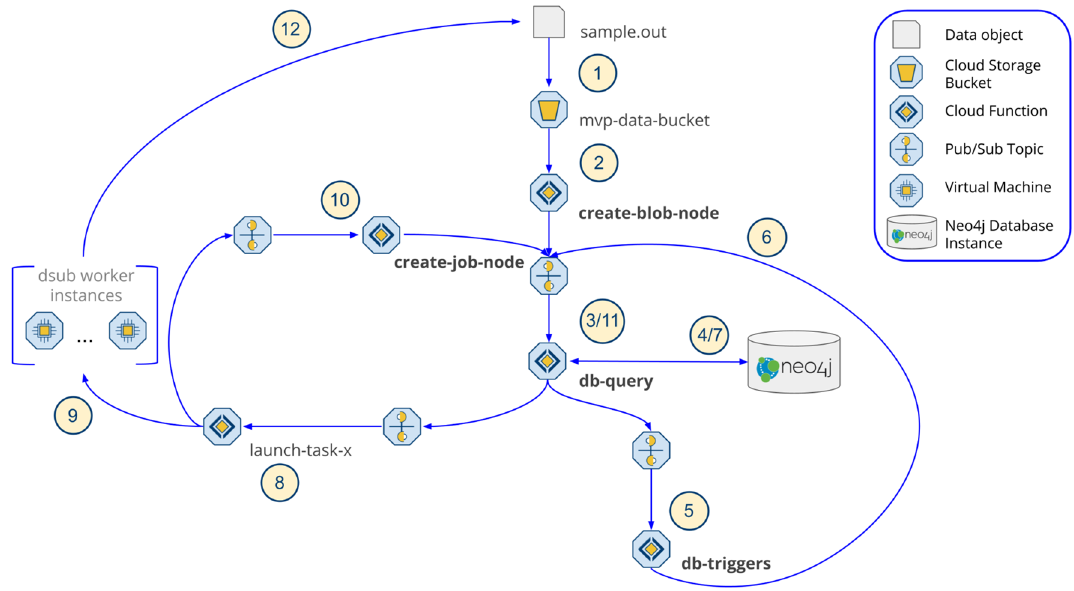
Figure 1. In Trellis, services are implemented as serverless functions that communicate with each other via message brokers. The state of the system is tracked using metadata stored in a graph database. This architecture is responsible for representing data objects as nodes in the database, checking their metadata against database triggers, launching jobs, and representing the jobs as nodes in the database. Users interact with Trellis by submitting queries to a GraphQL API. The standard operating cycle for tracking data and launching jobs starts when a data object is transferred into a storage bucket tracked by Trellis. The metadata for the object is used to create a reference to the object as a node in the database. The properties of that node are compared against all of the database triggers and launch operations appropriate for processing the data object. If the operation is a